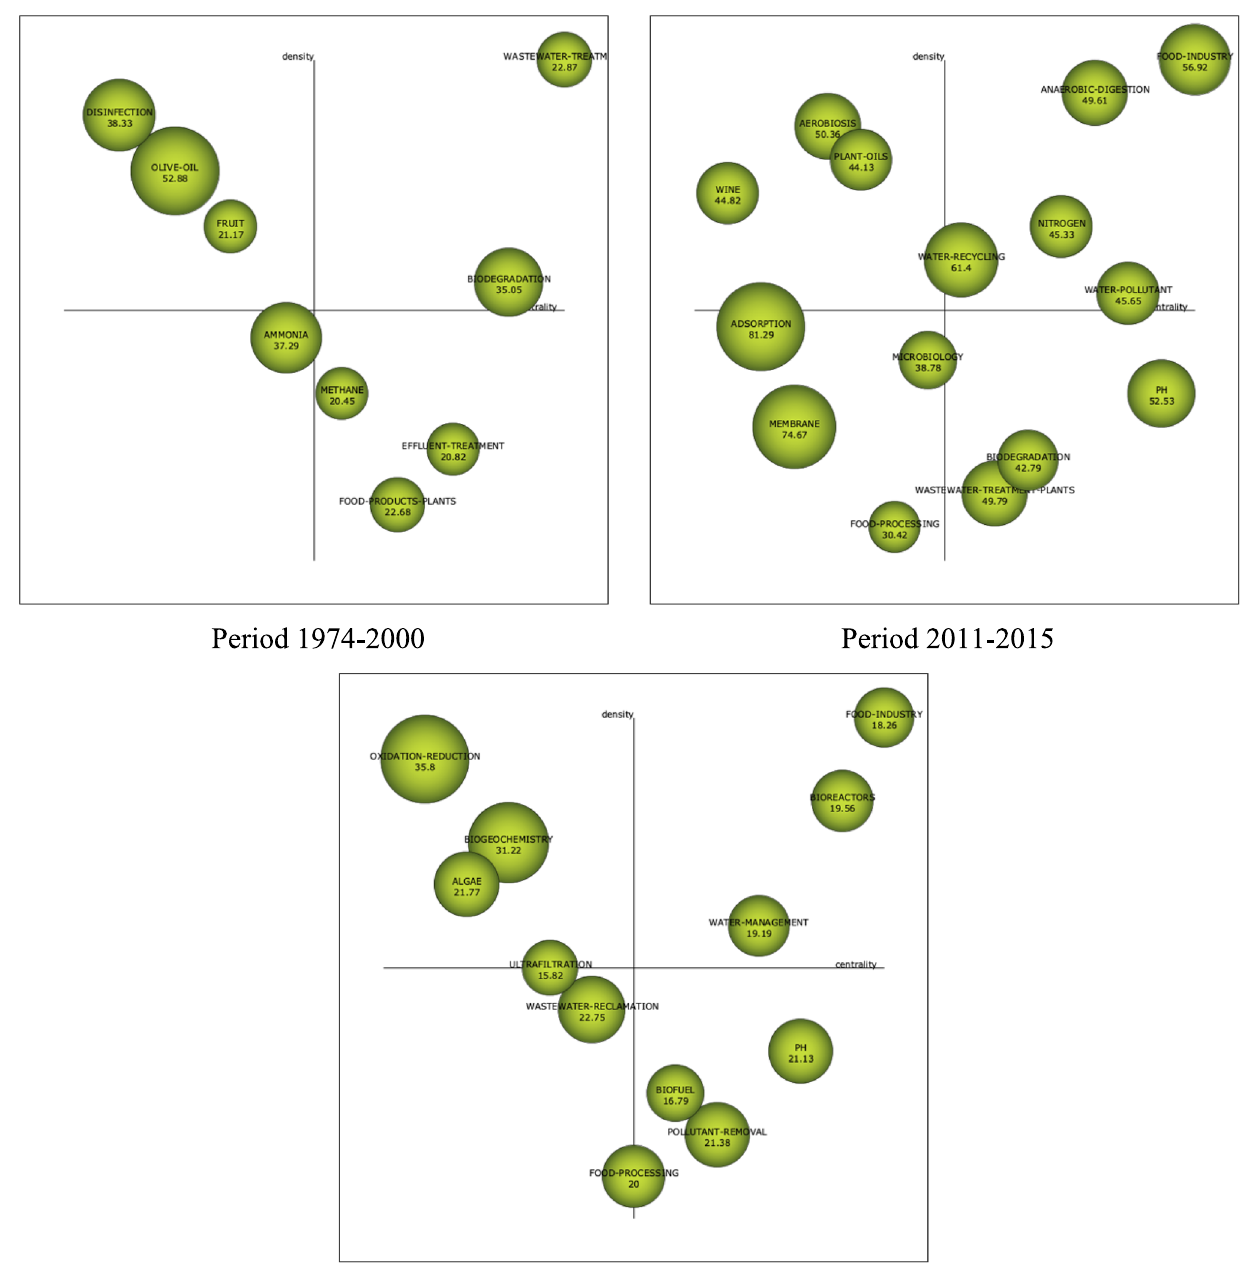
Fig. 10 Strategy diagrams in terms of average